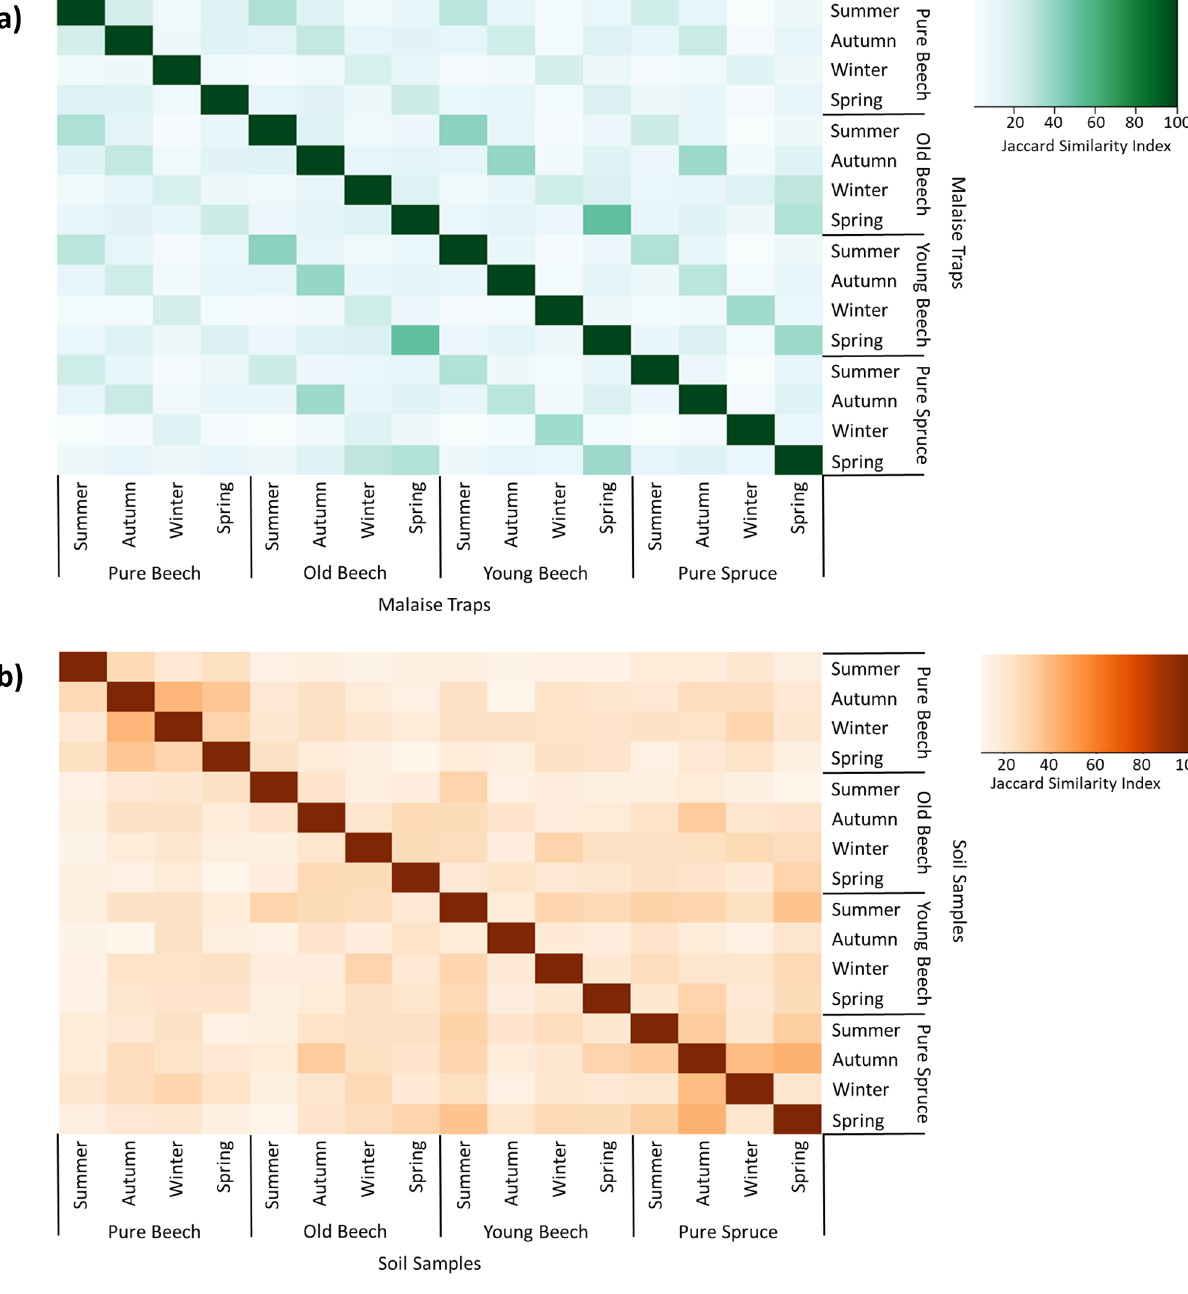
Figure 3. Heatmap showing similarity levels (Jaccard similarity index) between forest types on different sampling seasons. The Jaccard index was measured based on a presence-absence arthropod species matrix for a) soil samples and b) Malaise traps. Increasing similarities denoted by darker